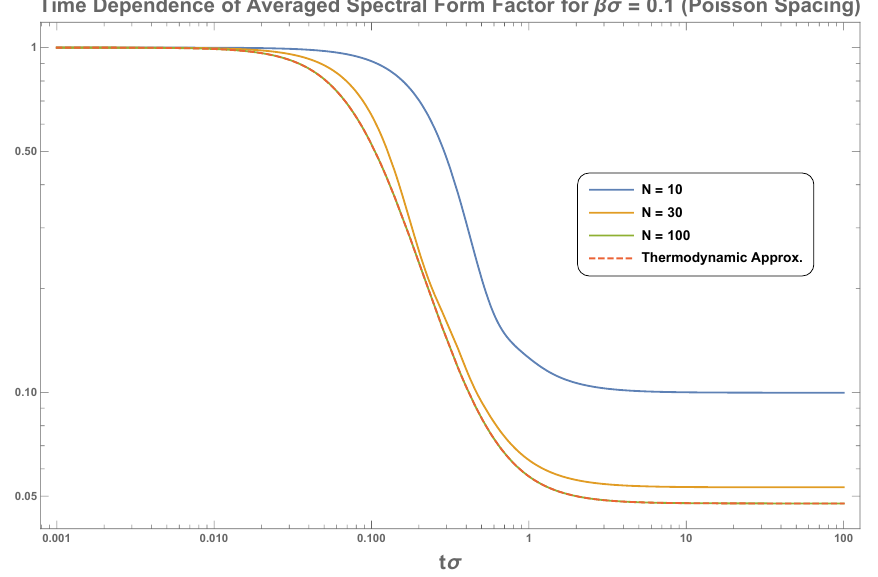
Figure 2 . Above is a Log-Log plot of the averaged spectral form factor of a spectrum generated by the i.i.d model with Poisson NNS distribution given by eq. (3.5). The temperature is fixed at βσ = 0 . 1 and we vary N . The plot illustrates how the form factors for larger values of N converge towards the thermodynamic approximation given in eq. (3.8).